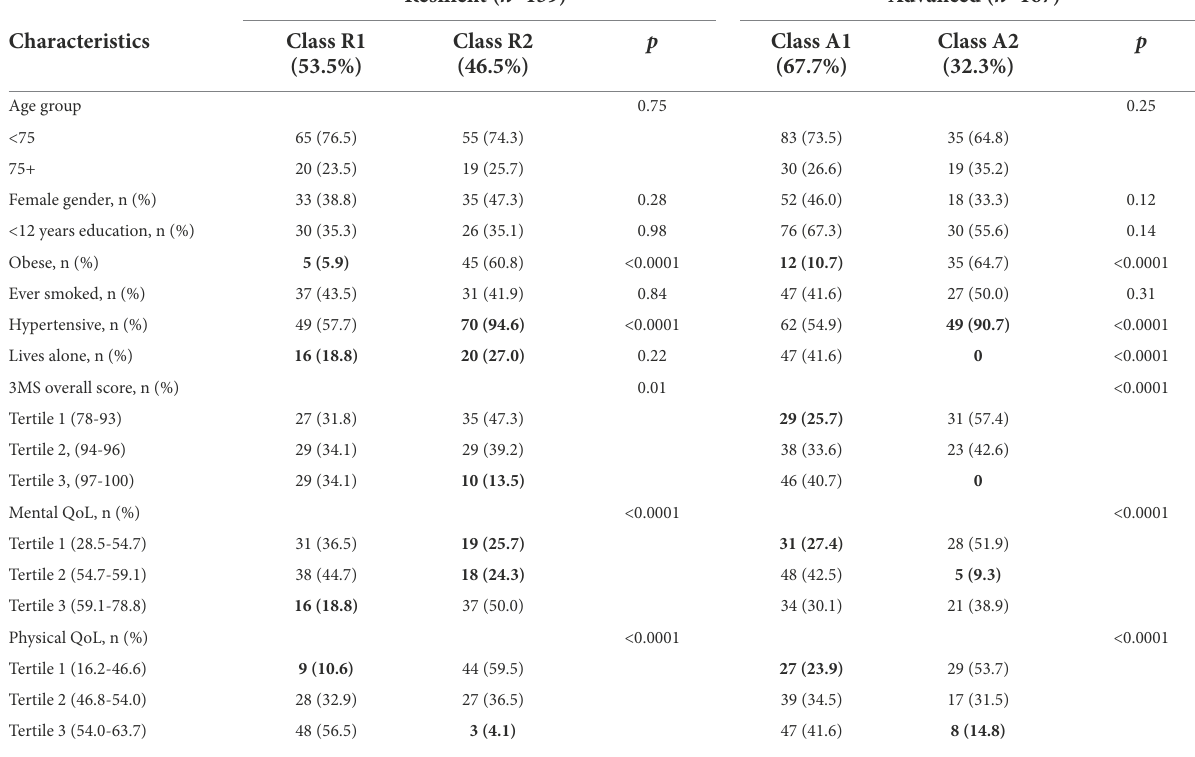
TABLE 1 Demographic and lifestyle characteristics of the latent classes, separately for the resilient and advanced brain aging. Resilient ( n =159) Characteristics